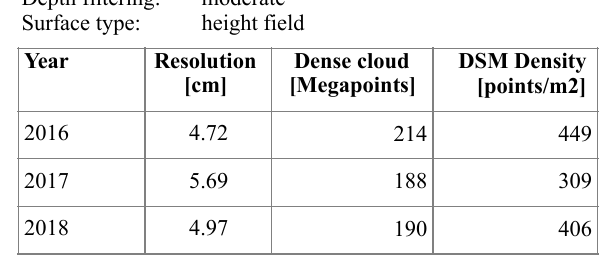
For all 3 years the resulting DSM show a sufficient resolution and related point density for the tracking of rock features (Table 2).